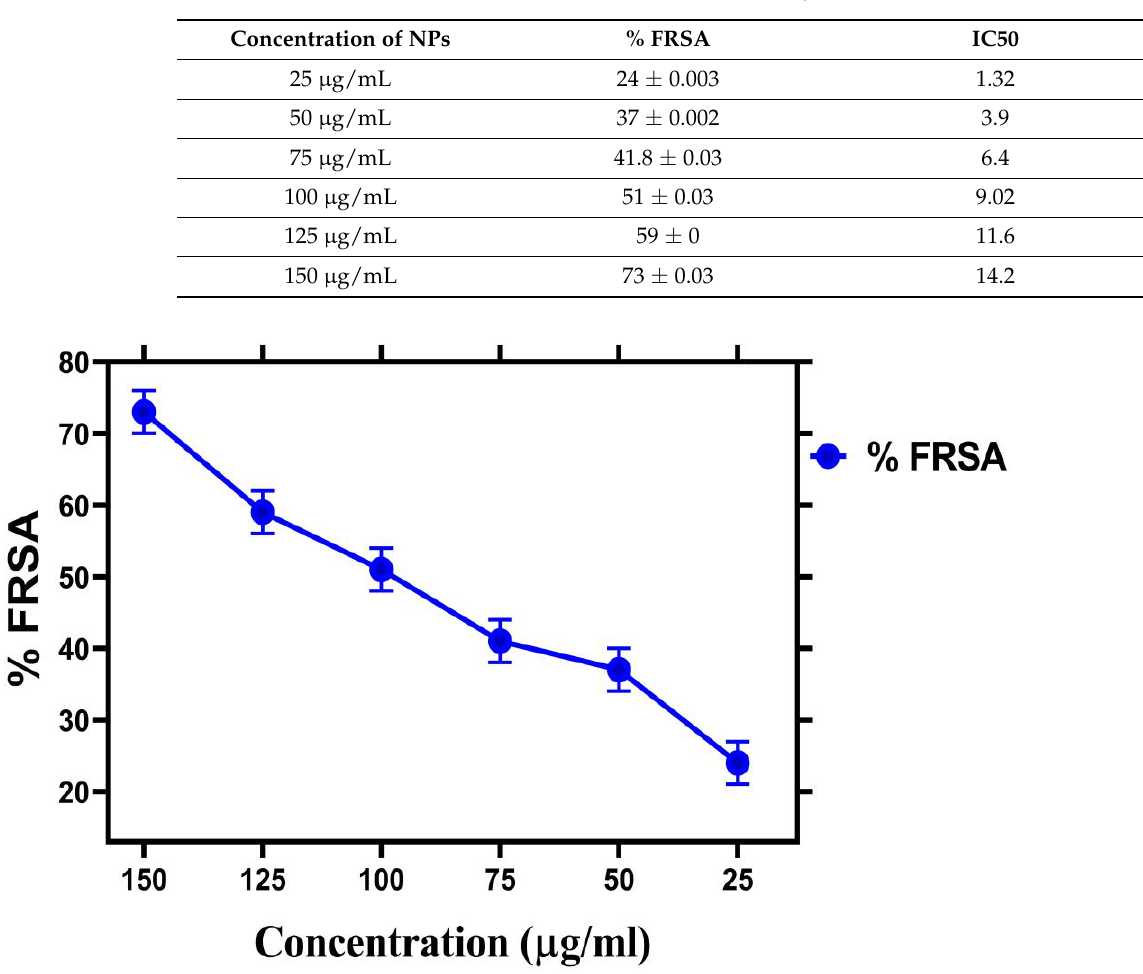
Table 3. IC 50 and FRSA values calculations for antioxidant assay.